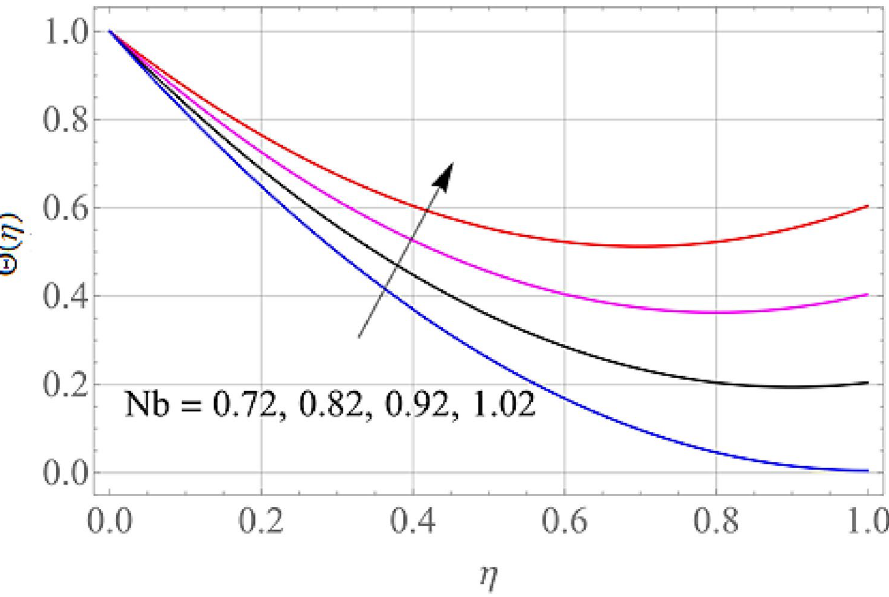
Figure 12. Alterations in �(η) as Nb , raises. When M = S = 0.1, Pr = 6.2, Gc = 0.2, Ec = 1, Nt = 0.3, Sc = 0.3 .